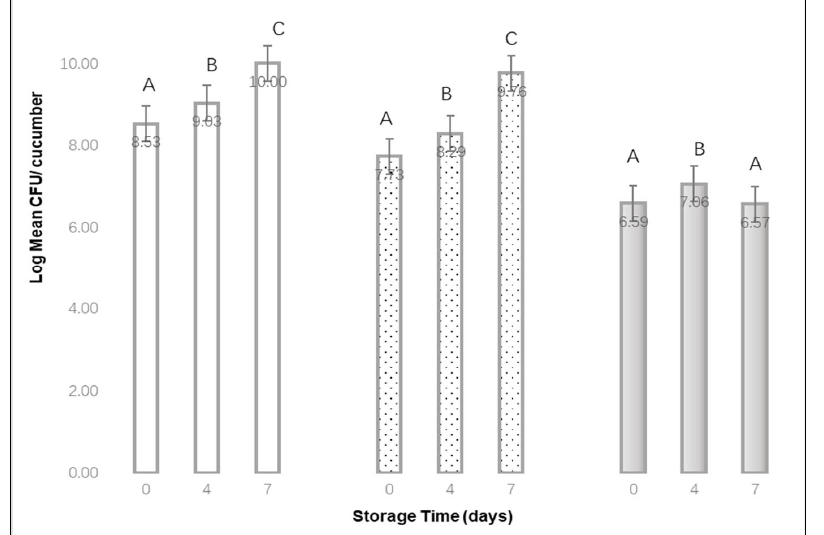
Figure 4. Log Mean CFU per cucumber recovered after different storage times, at 10°C, when treated with a 0 min , 2 min , or 10 min bubble stream. (mean of 3 replications × 3 samples each). A,B,C Denote significant differences in recovery ( p < 0.01) between storage times for each of the bubble treatment times.